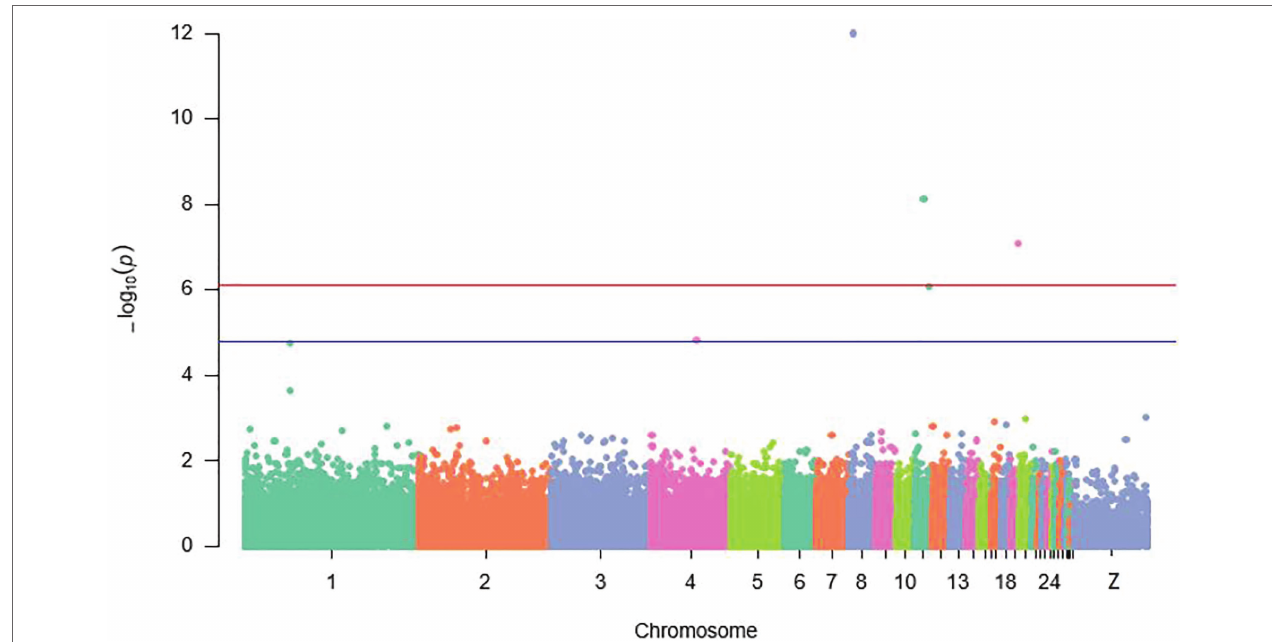
FIGURE 2 | Manhattan plot displaying significant and suggestive single nucleotide polymorphisms (SNPs) associated with IC body weight {the red line designates a Bonferroni-adjusted genome-wide threshold [ − log10 ( p ) ≥ 6.1] and the blue line indicates a suggestive genome-wide threshold [ − log10 ( p ) ≥